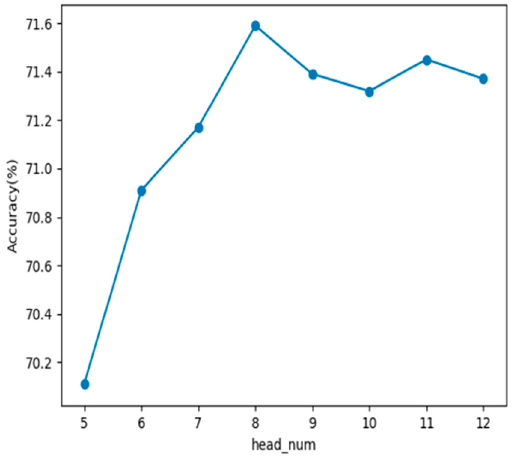
Figure 5. The accuracy score with different head_num.